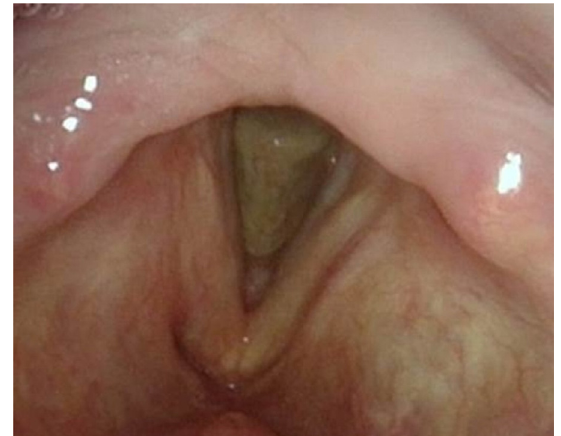
Figure 1 Contrast-enhanced computed tomography demon- strates an enhancing right laryngeal mass deeply located in the vocalis muscle.